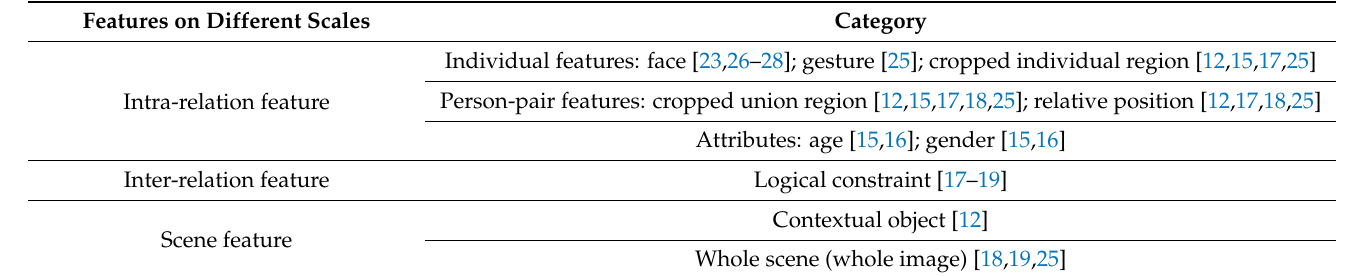
Table 1. Features on different scales for